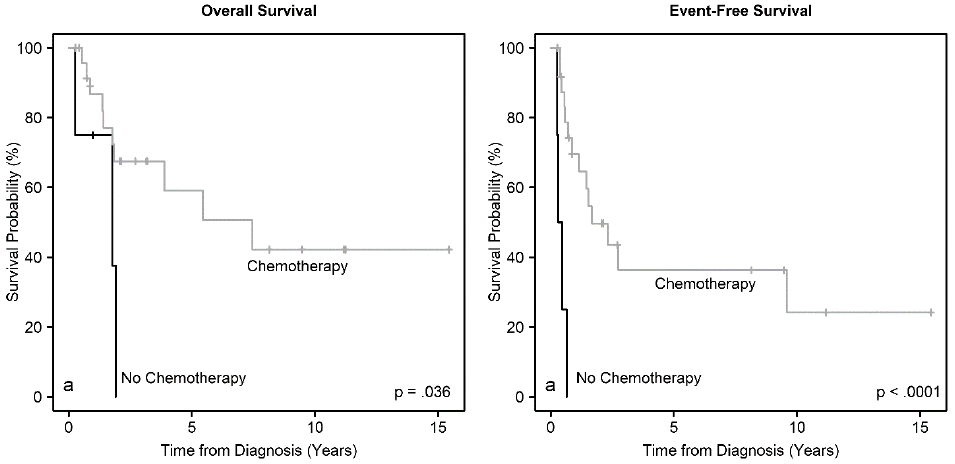
Figure 4. Overall survival and event-free survival distributions according to the use of chemotherapy.